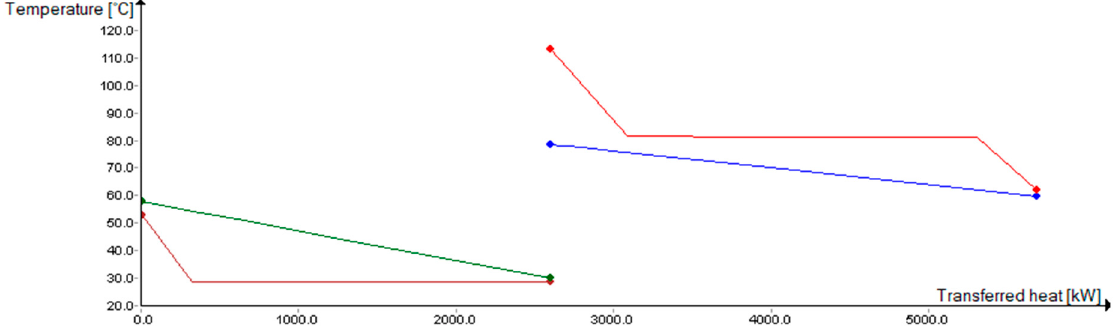
Figure 9. Diagram showing the temperature change of the basic variant condenser ( left ) and evap- orator ( right ).